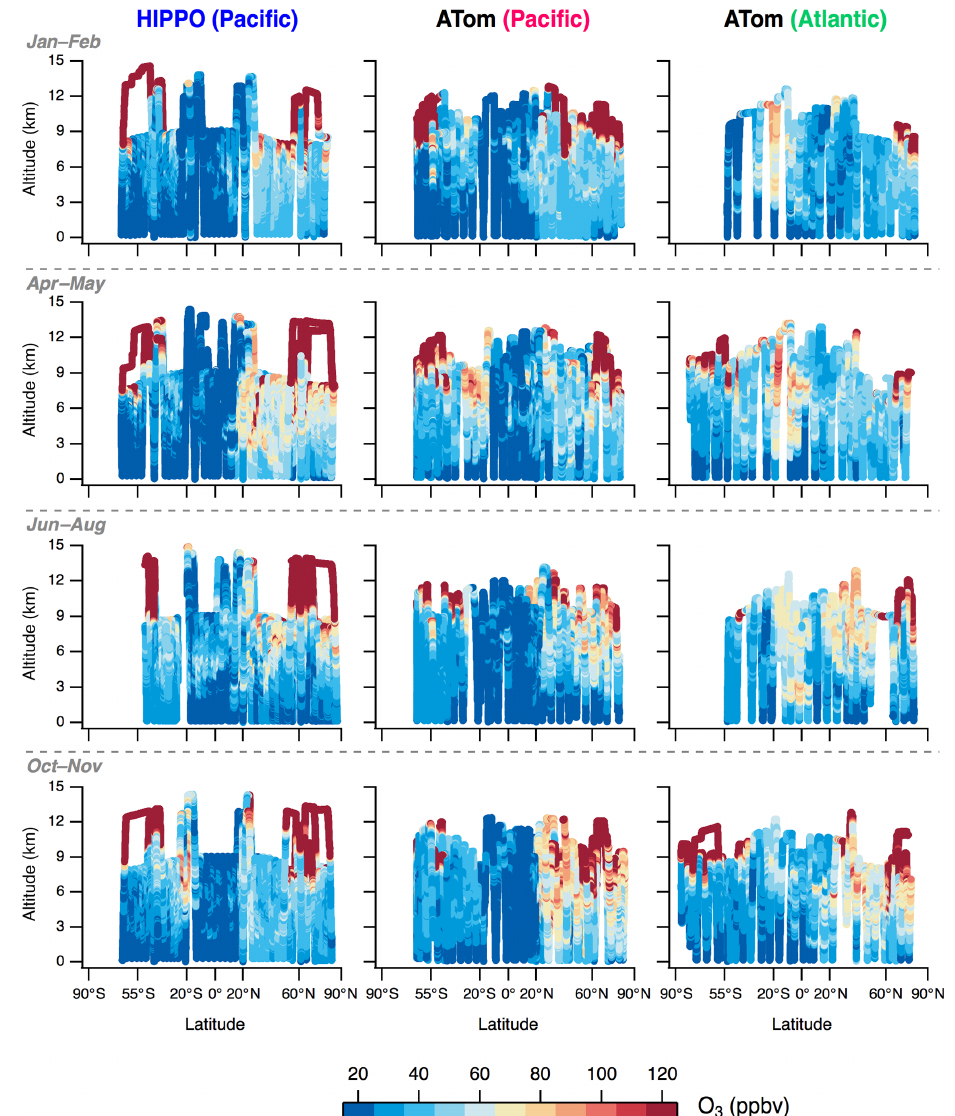
Figure 9. Global-scale distribution of tropospheric O 3 for each ATom and HIPPO seasonal deployment. The rows separate the seasonal deployments, whereas the columns indicate the mission and the ocean basin. The O 3 color scale ranges from 20 to 120ppbv, and all values outside of this range are shown using the same extremum color (red for values > 120ppbv and blue for values < 20ppbv). HIPPO deployments in June and August were